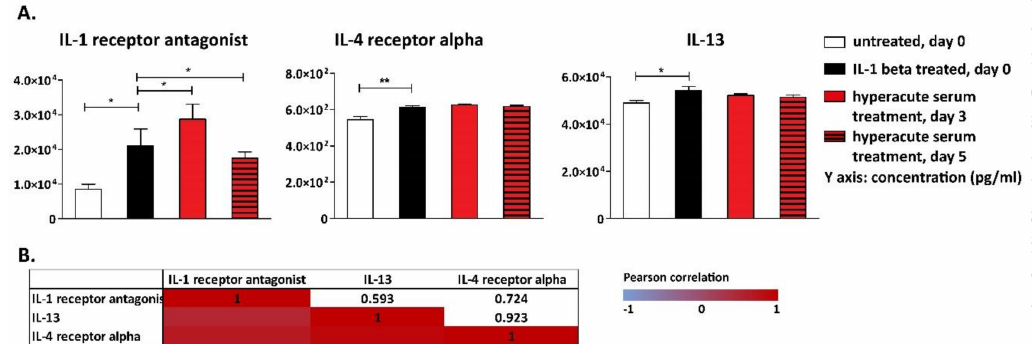
Figure 7. Anti-inflammatory cytokines detected in the tissue culture supernatant. IL-1 β triggered an anti-inflammatory response evidenced by elevated interleukin-1 antagonist (IL-1RA), interleukin-4 receptor alpha (IL-4R α ), and IL-13 levels. IL-1RA significantly increased to day 3 in response to hyperacute serum treatment, but decreased until day 5, n = 12 ( A ). The significance level was p < 0.05, where * means that the p -value was between 0.05 and 0.01, ** means that p -value was between 0.01 and 0.001, and *** means that the p -value was lower than 0.001. The correlations of cytokine changes are presented in heatmap tables. Very strong correlations were found among all three anti-inflammatory cytokines ( B